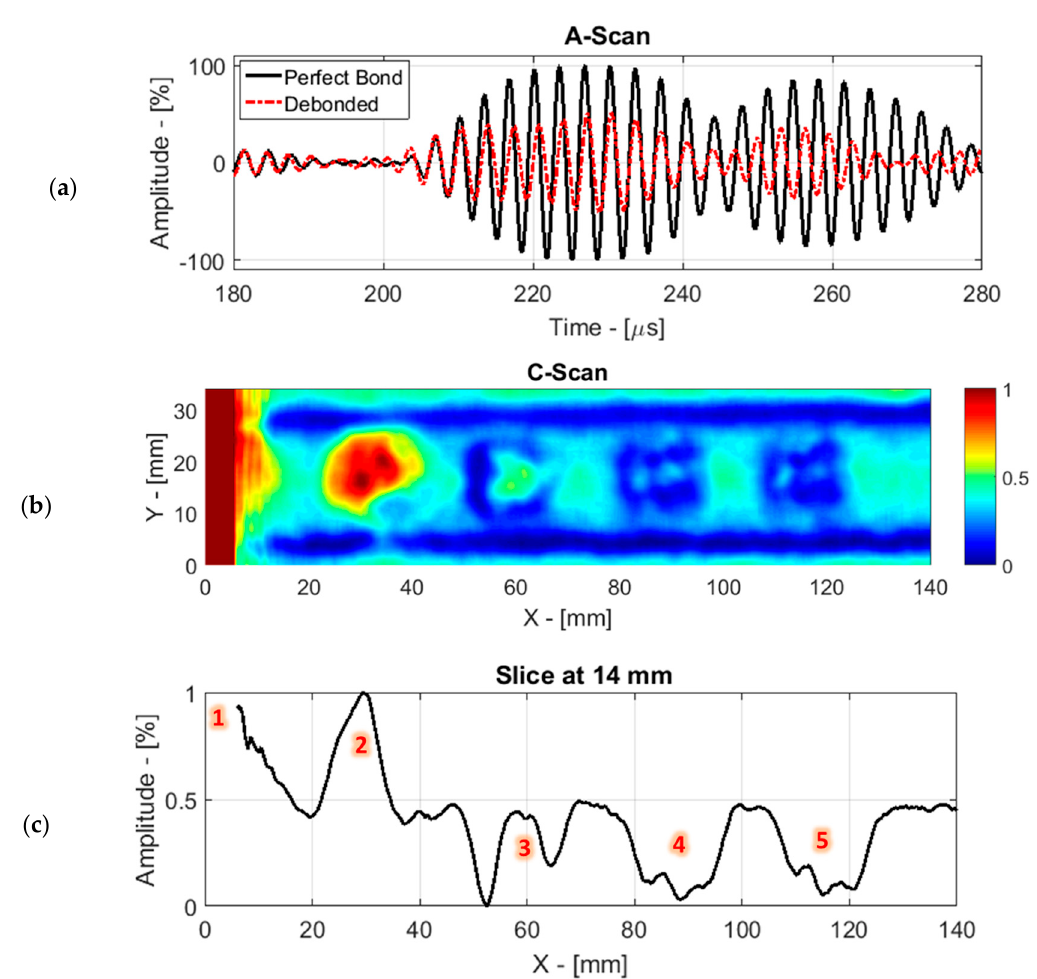
Figure 14. Results of the air-coupled through-transmission: ( a ) A-scan; ( b ) C-scan; ( c ) slice at Y = 14 mm.